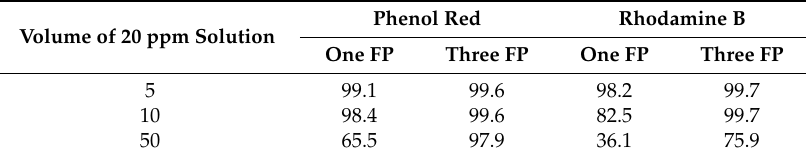
Table 1. Dye removal% from different volumes of a 20 ppm mixture of phenol red and rhodamine (each 10 ppm) using one and three nylon filter membranes (FP) at 50 mmHg.